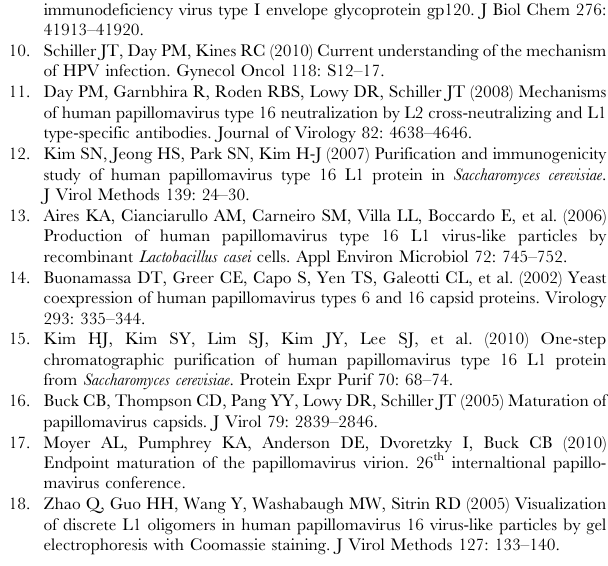
the extension of intermolecular disulfide bonding of polyclonal antibody and HRP-conjugated goat anti-rabbit IgG was used. Figure S2 Measurements of endotoxin levels contained in hHPV16 VLP and cHPV16 VLP. To measure the endotoxin levels, RAW264.7 (2 6 10 4 cells / well) cells were seeded in a 96- well cell culture plate 24 hours prior to stimulations. To block Toll-like receptor 4 on RAW264.7 cells, the cells were treated with 50 m g/ml of polymyxin B (Sigma, USA) for 30 min at 37 u C prior to LPS and HPV VLPs treatments. The cells were treated with 10 ng/ml, 10 m g/ml and 10 m g/ml, respectively. Four hours after the treatments, the levels of TNF- a in the culture supernatants was measured using an ELISA kit according to manufacturer’s instructions (BD Bioscience, USA). Values are presented as the means 6 SD of duplicate assays. Figure S3 Neutralization assay results. The mice were immunized three times with 1000 ng of hHPV16 VLP or cHPV16 VLP, in combination with aluminum hydroxide (protocol-2, Table 2). The mice sera were serially diluted and incubated with Optiprep density gradient-purified HPV16 PsVs for 1 h at 4 u C. The PsV and mice sera mixtures were added to pre-plated 293TT cells and cultured for 72 h at 37 u C. The secreted SEAP of each